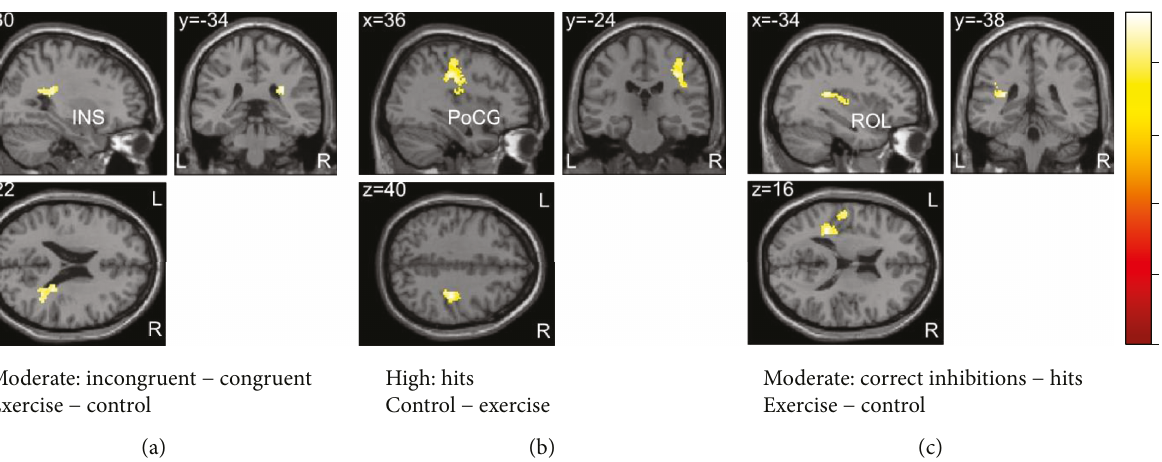
Figure 4: Correlations between cardiorespiratory fi tness (VO % ranking values) and changes in BOLD responses between the two 2peak conditions. (a) Flanker task: in the moderate-intensity group, fi tness correlated positively with di ff erential BOLD response ( exercise − control ) for the contrast incongruent − congruent in one cluster with peak activation in the right insula (INS). (b) Go/No-go task: in the high-intensity group, higher fi tness was associated with stronger exercise-related decreases in BOLD response ( control − exercise ) for the contrast hits in one cluster with peak activation in the right postcentral gyrus (PoCG). (c) Go/No-go task: in the moderate-intensity group, fi tness correlated positively with di ff erential BOLD response ( exercise − control ) for the contrast correct inhibitions − hits in one cluster with peak activation in the left rolandic operculum (ROL). p < 0 05 (FWE-corrected on cluster level, initial voxel threshold 0.001